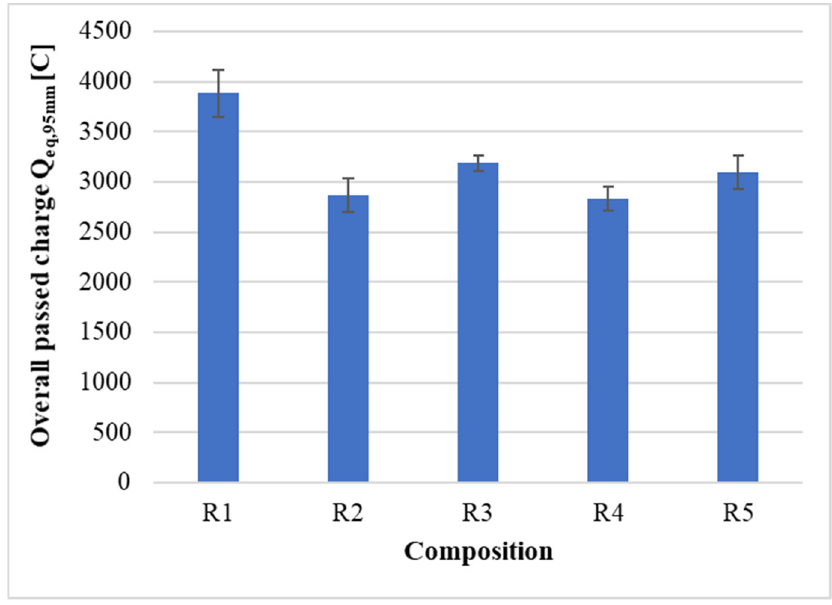
Figure 17. Results of the total charge transfer to the equivalent diameter of the test specimen.